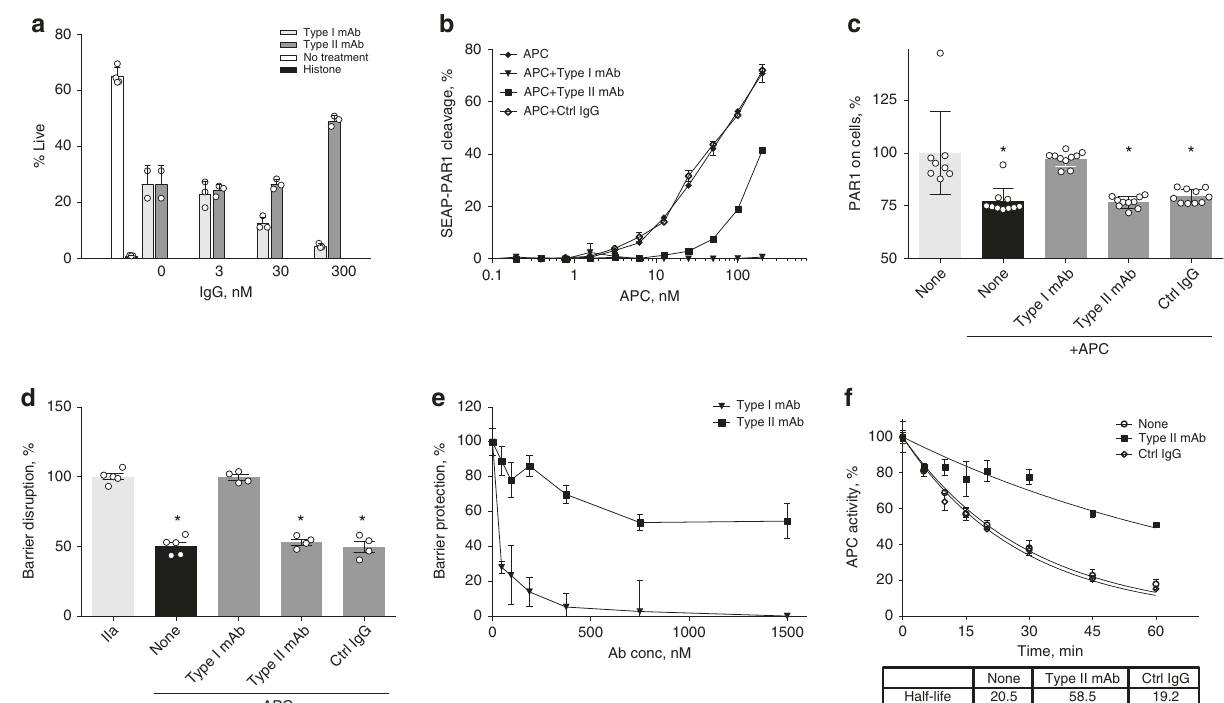
Fig. 4 Distinct effects of type I and type II mAbs on the cytoprotective activities of APC. a Histone-mediated cytotoxicity assay using HUVECs (% live cells after 2 h). Positive (50 µ g/mL histone 3, 0% live cells, black bar) and negative (no histone 3, 70% live cells, open bar) controls. Reduction of histone cytotoxicity by hAPC (20 nM, gray bars) in the presence of type I mAb (light gray) or type II mAb (dark gray). The results are shown as mean + SD of three independent experiments. b Effect of mAbs on PAR1 cleavage of SEAP – PAR1 reporter construct on transfected HEK293/wt-EPCR cells. Shown are mean ± SEM of n = 4 performed on two independent cell seedings. c PAR1 cleavage on EA.hy926 endothelial cells. The ATAP antibody reports PAR1 cleavage at Arg46 50 . Shown are mean ± SD of N = 10. * denotes p < 0.05 tested with ANOVA with Dunnett ’ s multiple-comparison test in both ( c ) and ( d ). d , e APC (50 nM)-mediated endothelial barrier protection in response to thrombin (2 nM)-induced barrier disruption of an EA.hy926 endothelial cell monolayer was determined using the iCelligence system. d Permeability is expressed as the percentage of maximal barrier disruption induced by thrombin (100%) in the absence of APC. Shown are mean ± SEM of N = 4. e Effect of the mAbs on APC ’ s barrier protection is expressed as the percentage of the maximal barrier-protective effect of APC in the absence of mAbs. Shown are mean ± SEM of N = 3. f Effect of the type II mAb on the inactivation of APC in human plasma by SERPINs. Data represent mean values ± SD from at least three independent experiments. HUVEC human umbilical vein endothelial cells, SEAP – PAR1 secreted embryonic alkaline phosphatase (SEAP) fused to the N terminus of human PAR1, HEK293/wt-EPCR HEK293 cells with stable expression of wild-type human EPCR, SERPINs serine protease